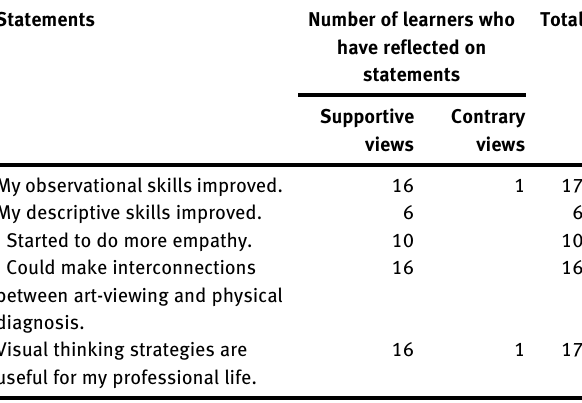
Table  : Re fl ection results of the learners about the designed course. The statements are the common topics in re fl